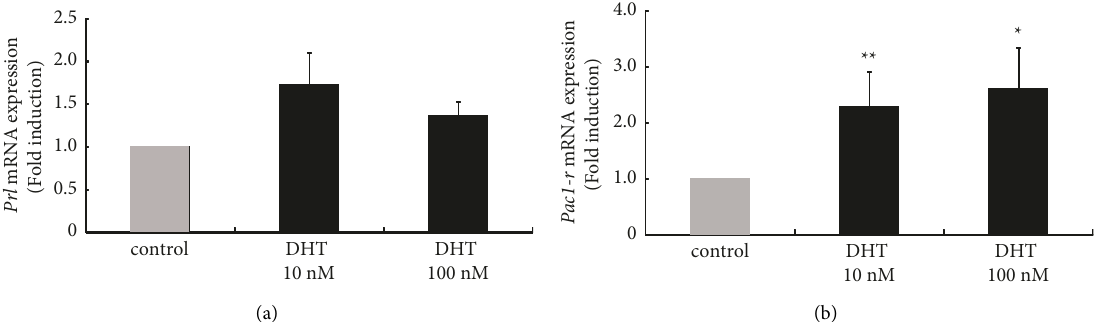
Figure 6: Effect of dihydrotestosterone (DHT) stimulation on Prl and Pac1-r gene expression in rat somatolactotroph GH3 cells. GH3 cells were stimulated with the indicated concentrations of DHTfor 24h After stimulation, mRNA was extracted and reverse transcribed, and Prl (a) and Pac1-r (b) mRNA levels were measured by quantitative RT-PCR. Samples from each experimental group were run in duplicate and normalized to the mRNA levels of the housekeeping gene Gapdh. The results are expressed as fold induction over unstimulated cells and presented as the mean ± SEM of three independent experiments. ∗∗ P < 0 . 01, ∗ P < 0 . 05 versus